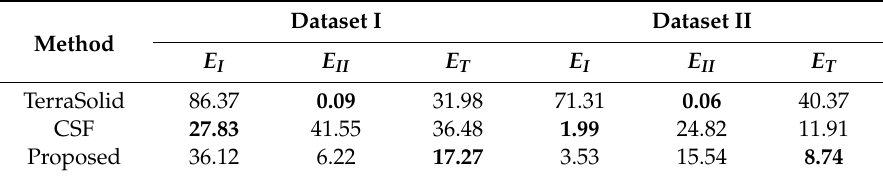
Table 2. Comparison of accuracy with handcrafted-based methods on dataset I and II.